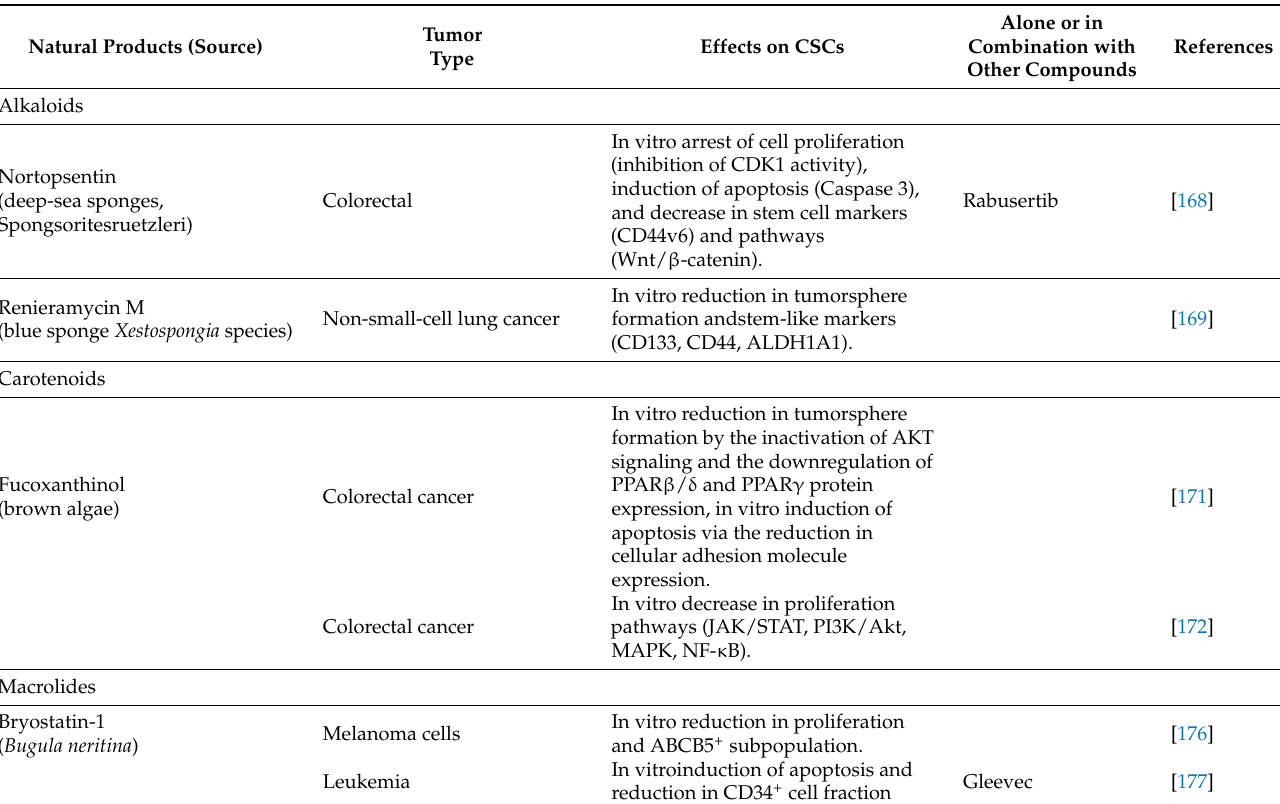
Table 3. NPs derived from marine sources and their effects on CSCs.